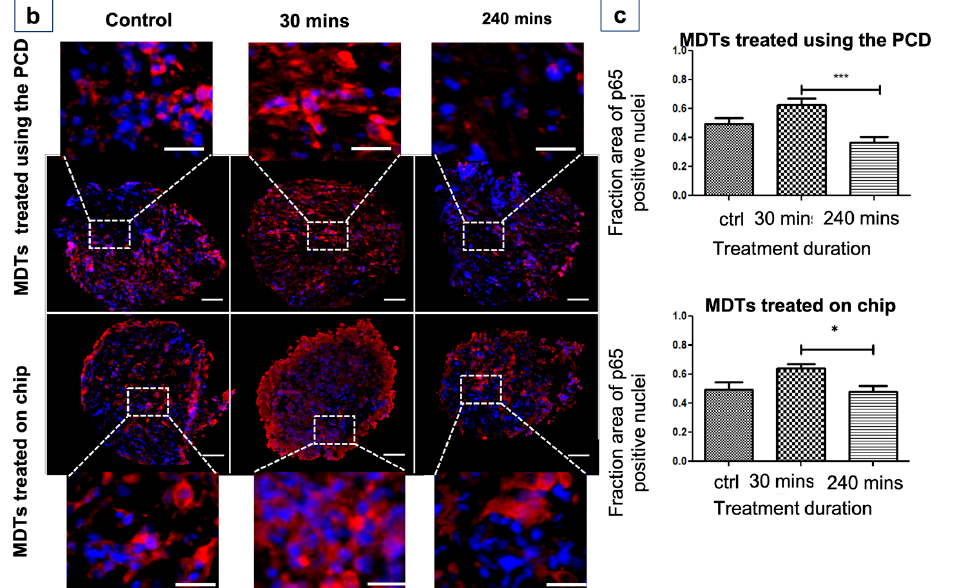
Figure 6. The PCD drug screening platform can recreate the on-chip response of tumour models to a cytokine. Xenograft cell line MDTs (TOV 21G) were treated with a TNF solution for different durations using the PCD, as well as on-chip for comparison ( a ). Fluorescence micrograph of cryosections of OCT-embedded tissue that have undergone immunofluorescent (IF) staining ( b ). Changes in the nuclear translocation of p65 were quantified in the IF staining on MDT cryosections ( c ). Red: p65 and blue: DAPI. Scale bars = 20 µ m for zoomed-in MDTs, and 100 µ m for whole MDTs. N = 3 experiments and a minimum of three MDTs tested per condition. Error bars = SEM. * p < 0.05; *** p < 0.0001.